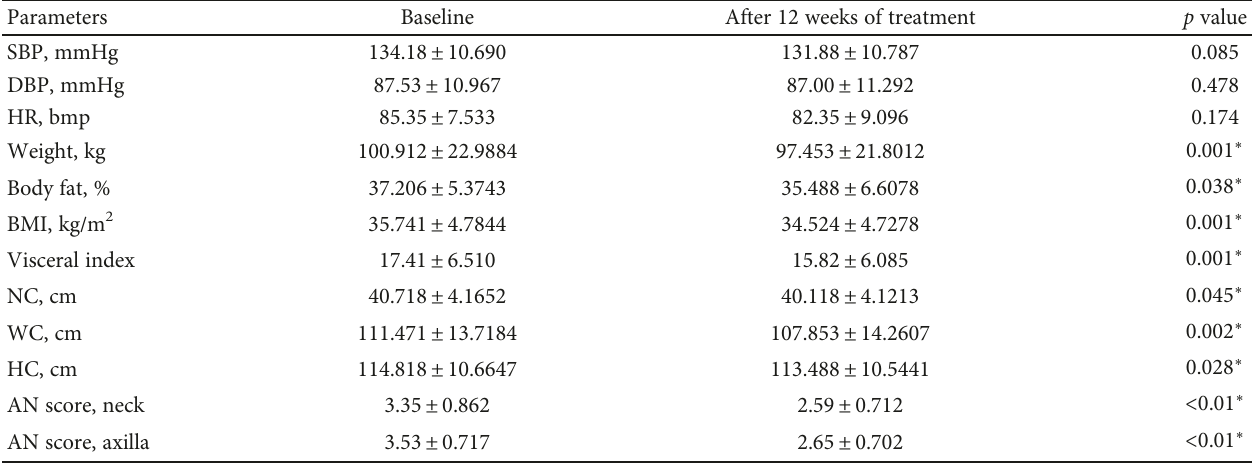
Table 2: Physiological measures.